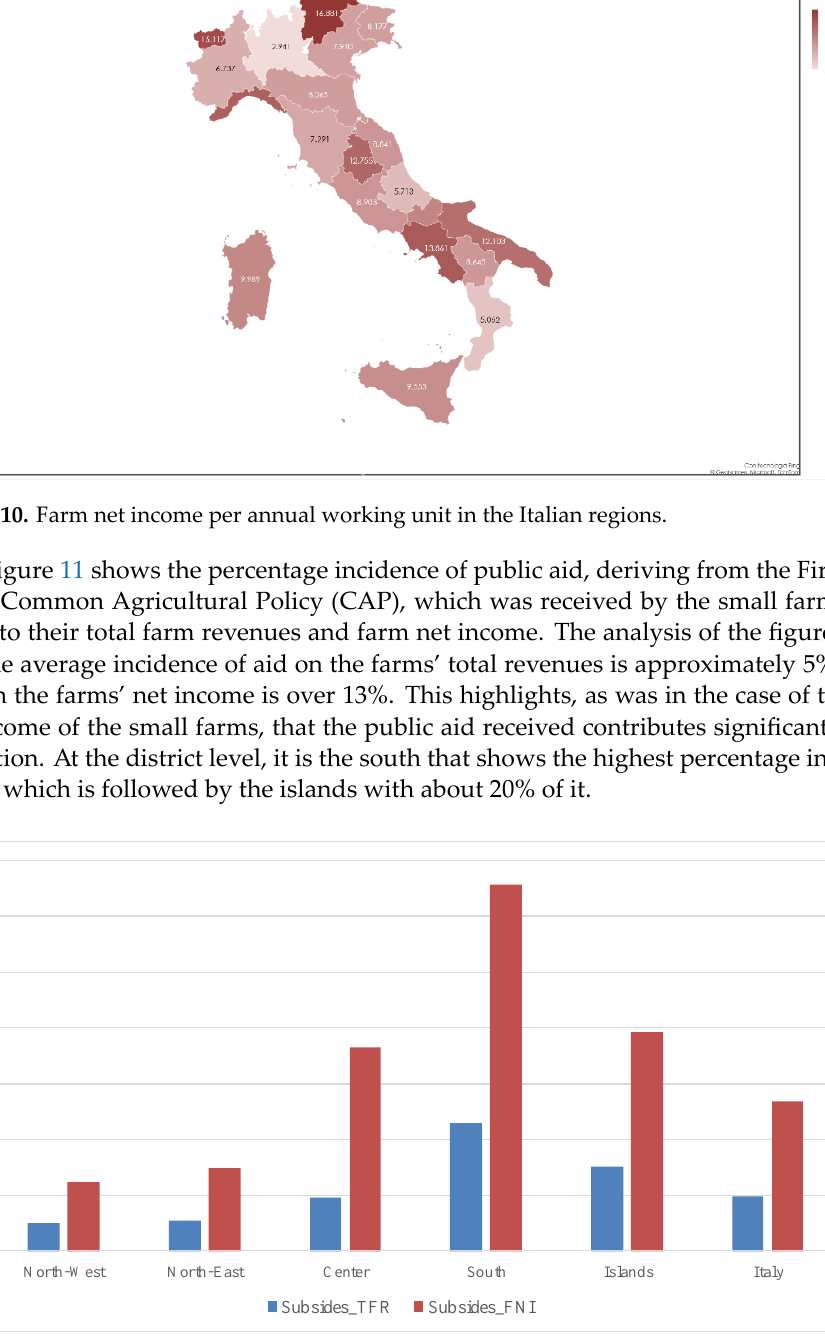
Figure 11. Percentage incidence of EU aid (I Pillar- CAP) on total farm revenues (TFR) and farm net income (FNI) by district. Source: Our elaboration on FADN data, 2018 – 2020.